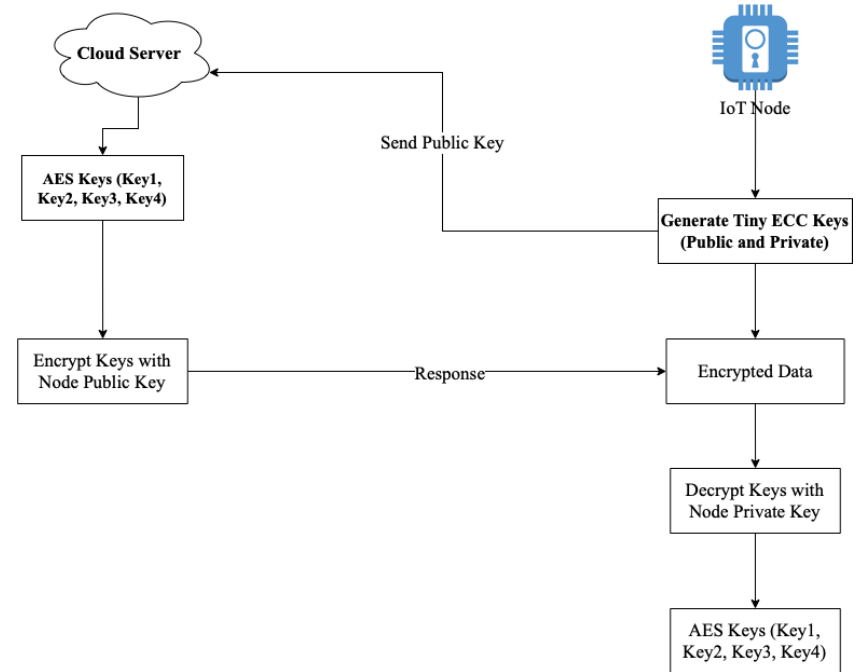
Figure 5. Key exchange